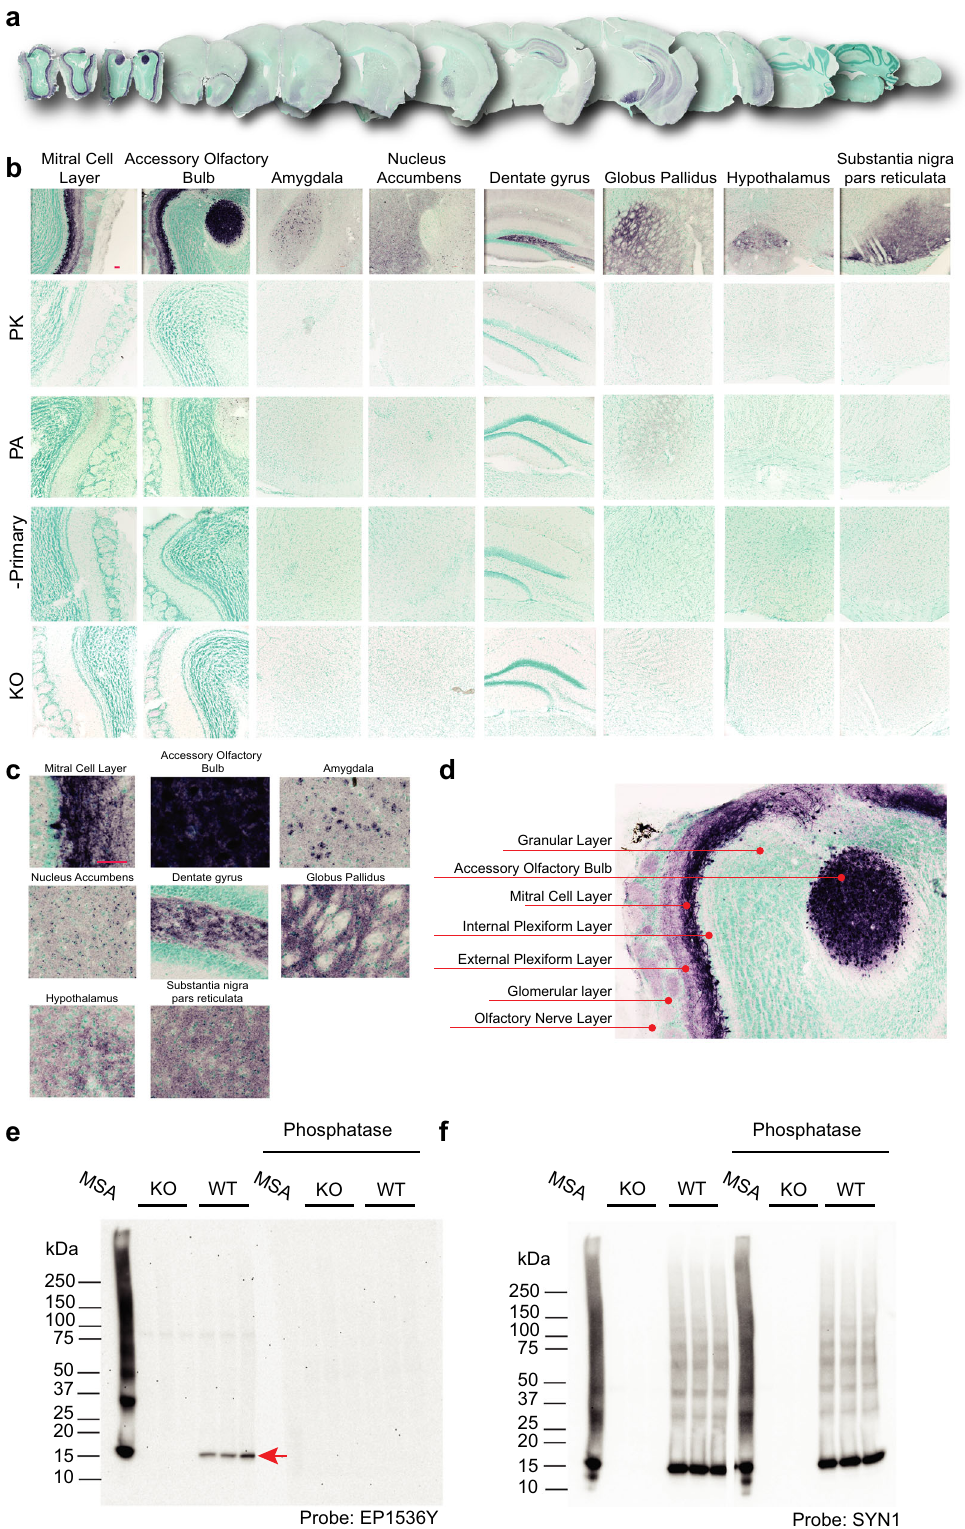
PSER129 was not observed, even after PK digestion, suggesting these two antibodies preferentially label different alpha-synuclein pools, a phenomenon that has been described in several other reports 14,20 and observed here (Supplementary Fig. 7).